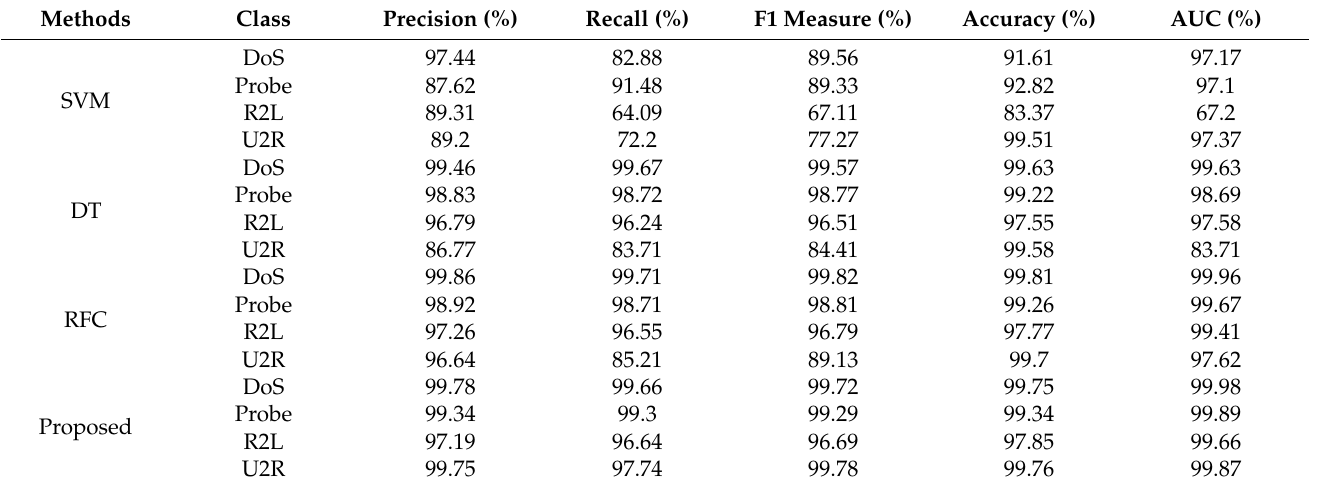
Table 3. Performance evaluation for the proposed SMO-HPSO for NSL-KDD dataset to multiple attack classes.